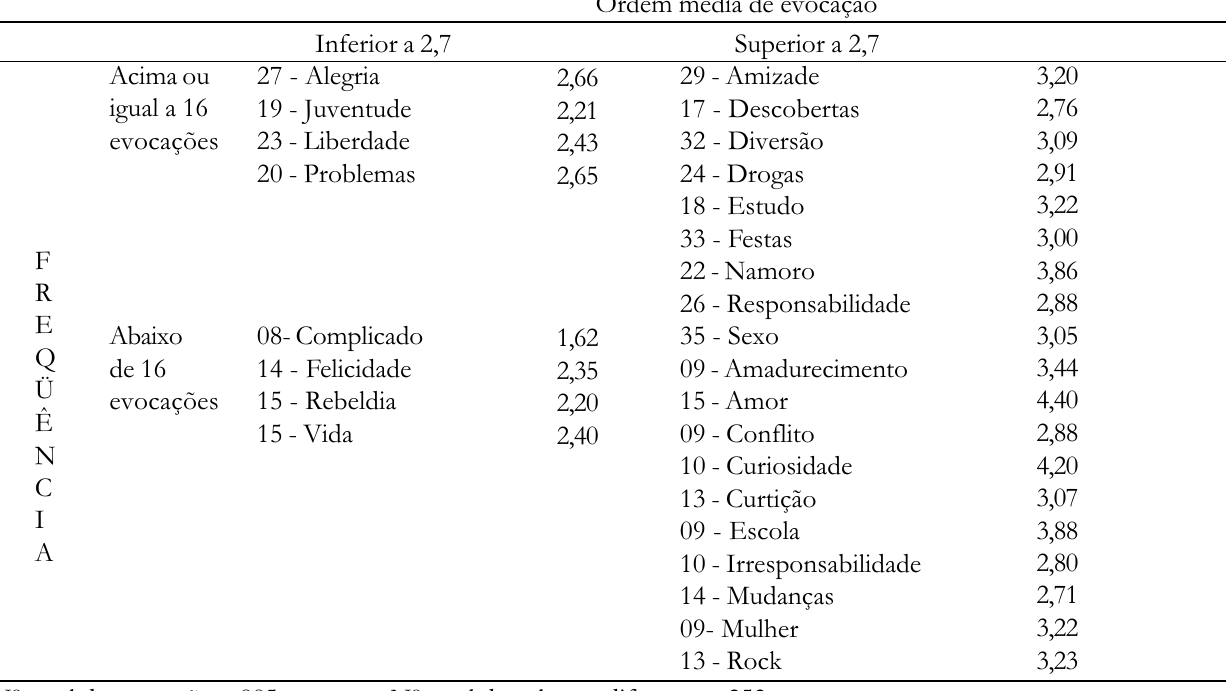
para anÆlise do grupo inteiro: Saœde, Liberdade, Curti(cid:231)ªo, Delinq(cid:252)Œncia, Futuro, Transi(cid:231)ªo, Relacionamento Afetivo, Fase Dif(cid:237)cil, Fase Boa, Atributos Positivos.